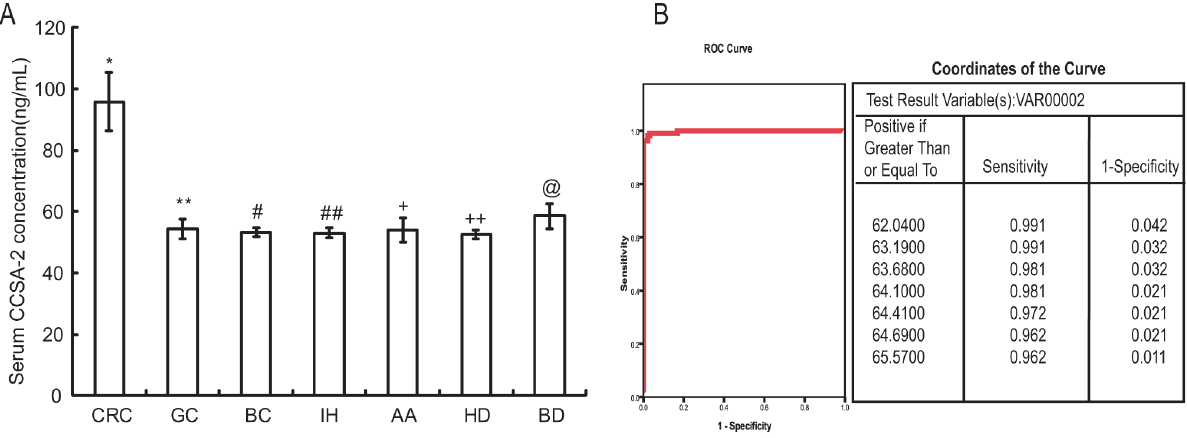
Figure 1. The use of serum CCSA-2 to detect CRC. (A) Comparison of serum CCSA-2 levels in colorectal cancer patients and other individual groups. *: the serum CCSA-2 concentration in CRC patients was significantly higher than each of the other individual groups( P , 0.01); **, # , ## , + , ++ ,@: there were no statistical significances between other couple groups ( P . 0.05). (B) Receiver operator characteristic (ROC) curve for serum CCSA-2 in separating colorectal cancer patients and other individuals. CRC: colorectal cancer; GC: gastric cancer; BC: breast cancer; IH: inguinal hernia; AA: acute appendicitis; HD: healthy donor; BD: benign disease.